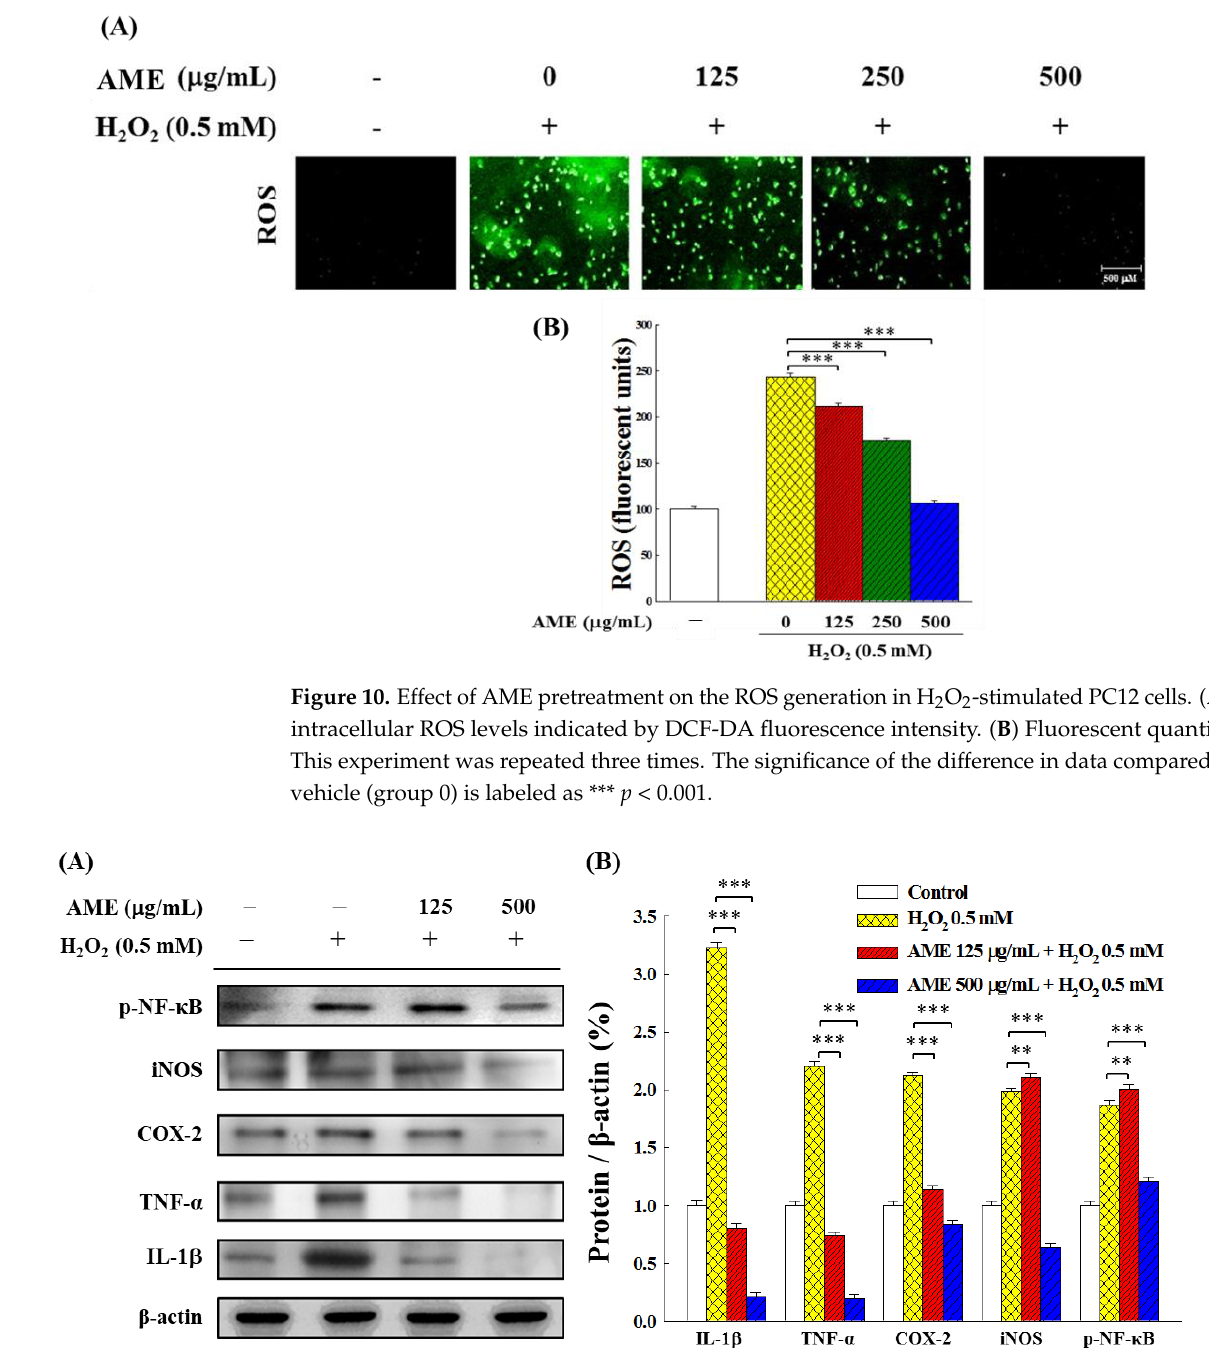
Figure 11. Effect of AME pretreatment on the expressions of pro-inflammatory cytokines and mediators in H 2 O 2 -stimulated PC12 cells. ( A ) Changes in protein expression. ( B ) Densitometric quantitation. The data were estimated from triplicate independent experiments. The control group was the PC12 cells grown without treatment with extract sample and H 2 O 2 stimulation. The protein expressed by this group was set as 1.0. The significance of the difference in data compared to the vehicle group is labeled as ** p < 0.01 and *** p <